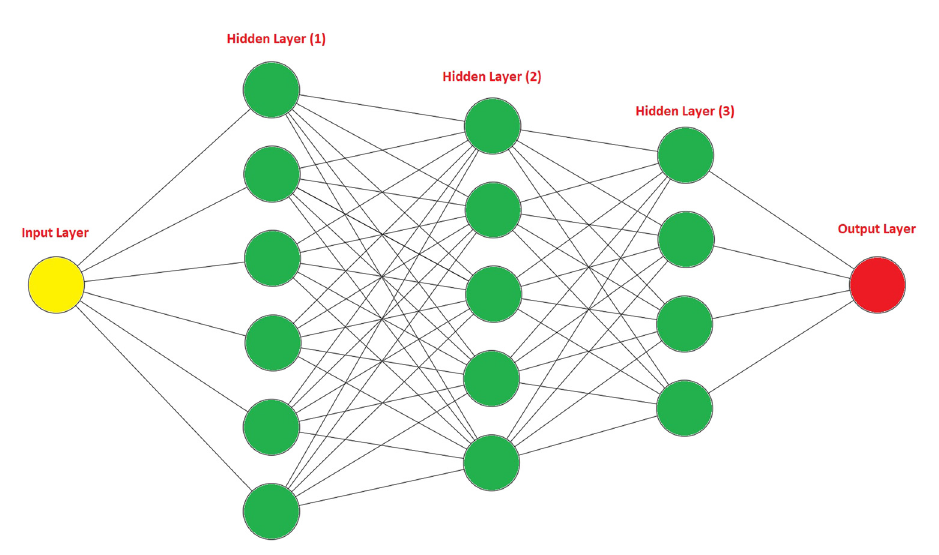
Figure 4: Structure of the used